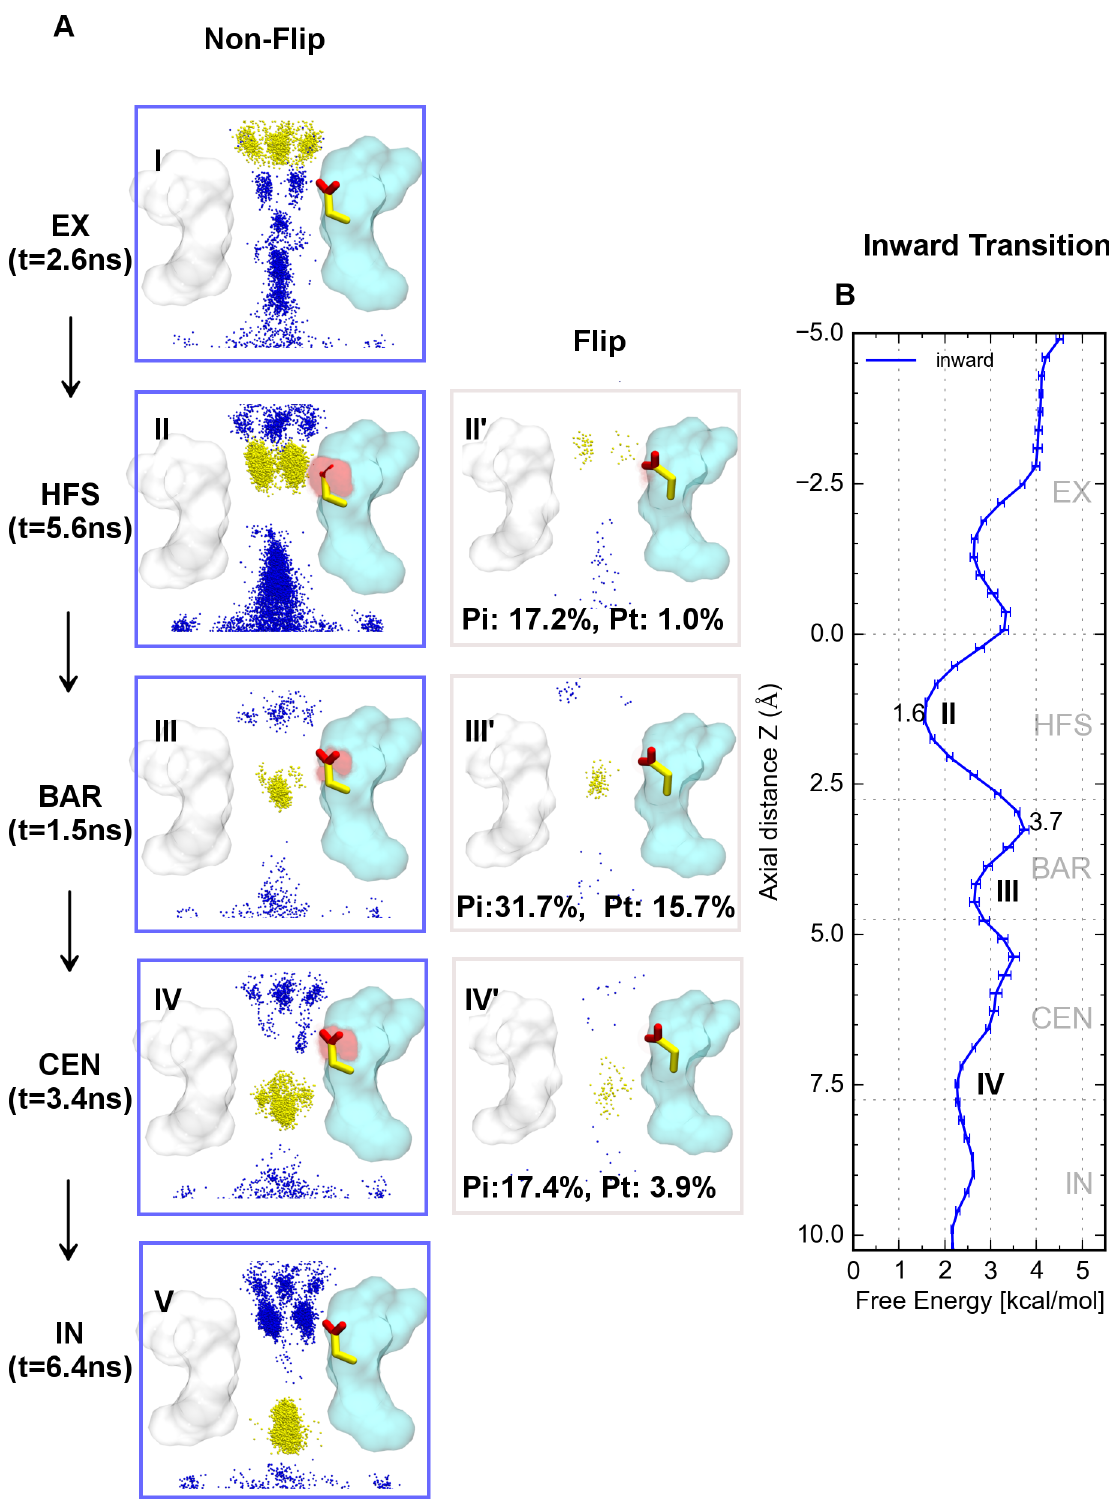
Figure 6. Inward ionic binding modes and PMF. A) Overlay of the conformational space of the probe ions (yellow), coupling sodium ions (blue) and E53 carboxyl oxygen distributions (transparent spheres with different intensity) for different ionic binding modes at different interaction sites. A snapshot of a typical E53 sidechain conformation is shown as stick representation (red, carboxyl oxygens; yellow, sidechain carbons), I–V are non-flip binding modes and II 9 –IV 9 are flipping binding modes for sites S HFS , S BAR and S CEN . Arrows indicate the direction of ion conduction; B) 1-D PMF of inward conduction in SF region, the largest free energy barrier is labeled by a terminal peak and well, corresponding positions of typical binding modes on the energy profile are labeled. Error estimations shown in the figure are S.E.M.